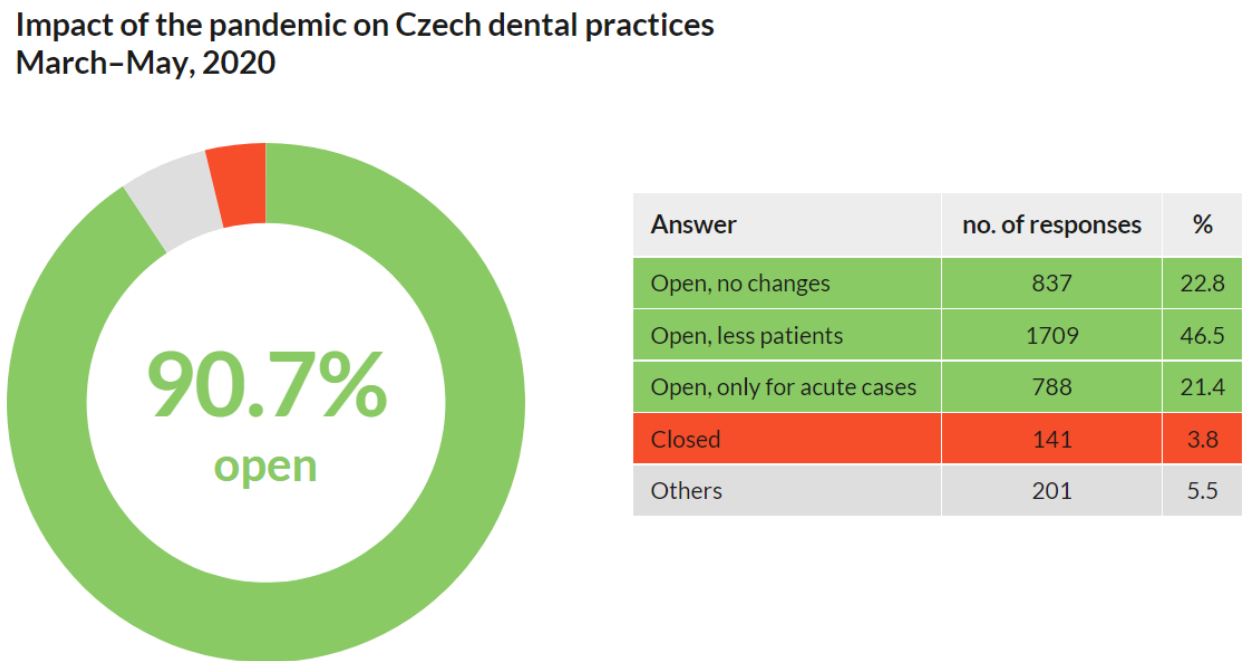
Figure 2. Impact of the pandemic on Czech dental practices from March to May of 2020. More than 90% of them remained open.